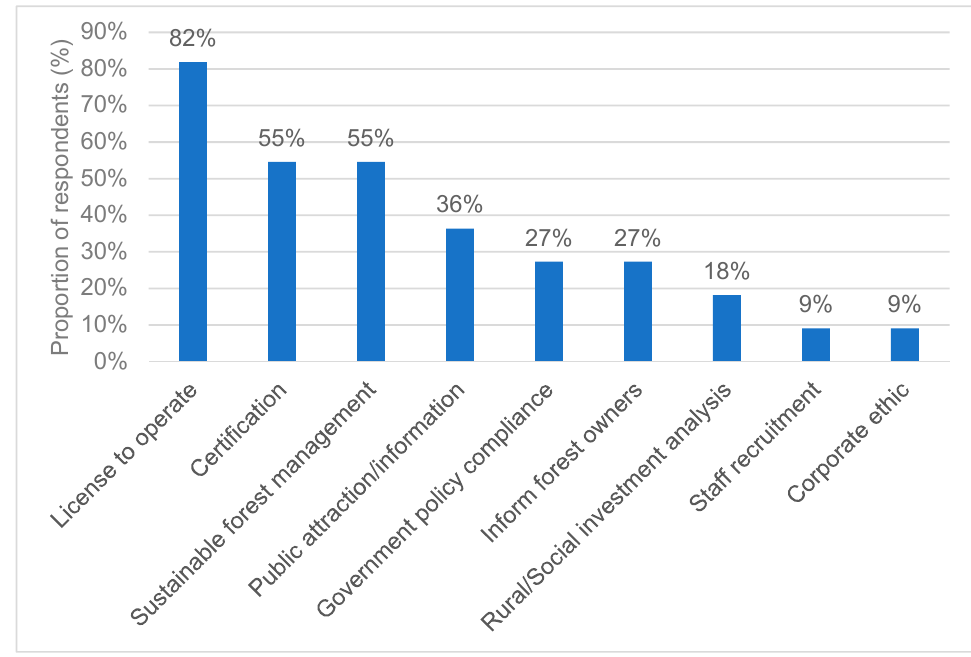
Figure 6. Relevance of the ES framework for the forestry business (n = 11).